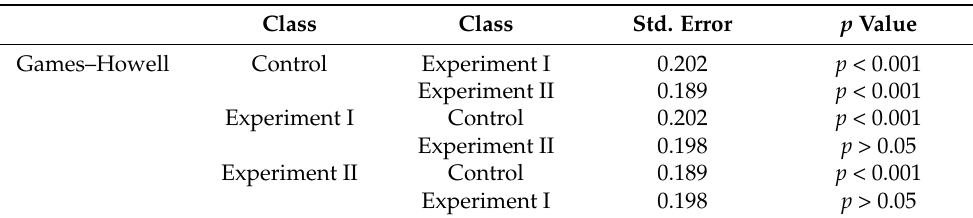
Table 4. ANCOVA learning satisfaction for the three classes.